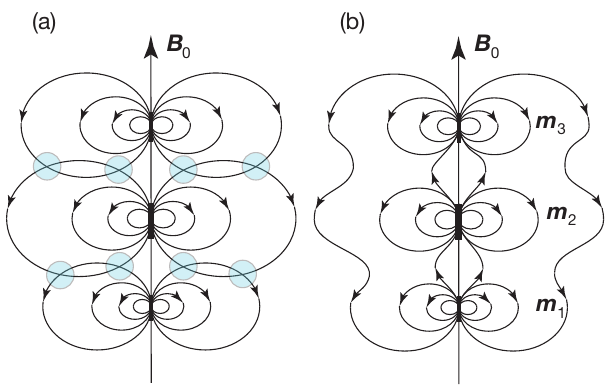
Fig. 3. The external dipolar magnetic fields of three electron holes aligned on an ambient magnetic field line. The field sources are the proper magnetic moments m i , generated inside the holes (i = 1 , 2 , 3 ) . Along the magnetic field, the holes attract each other. (a) The original field configuration. The blue circles indicate the sites of hole-magnetic field merging (reconnection). One should note that these ‘reconnection sites’ are embedded into the strong ex- ternal field that introduces a magnetic asymmetry of reconnection, which in the figure is neglected. (b) Magnetic field configuration (neglecting the asymmetry) caused after field line merging has oc- curred and fields have not completely relaxed